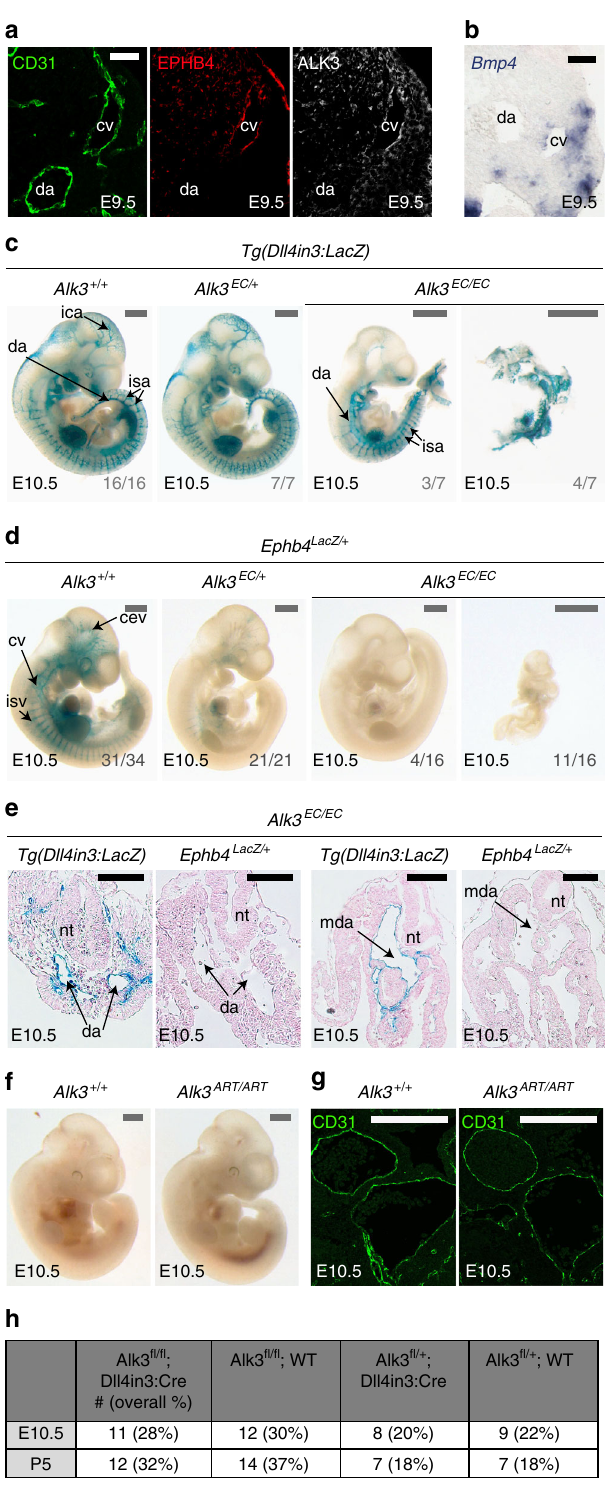
and 3 individually in tg(Ephb4-2:GFP) fi sh using MOs known to